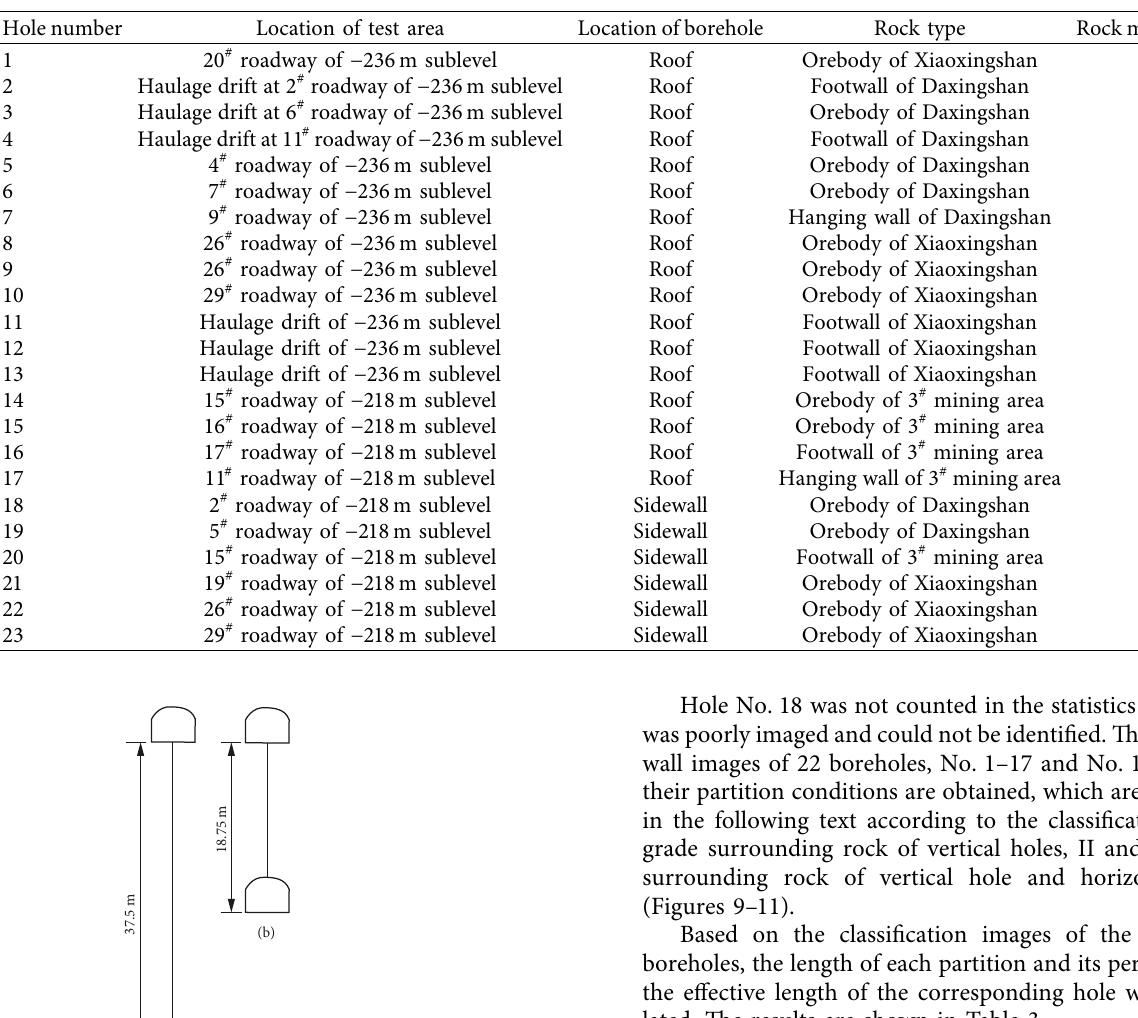
Table 2: Summary of the 23 test areas.